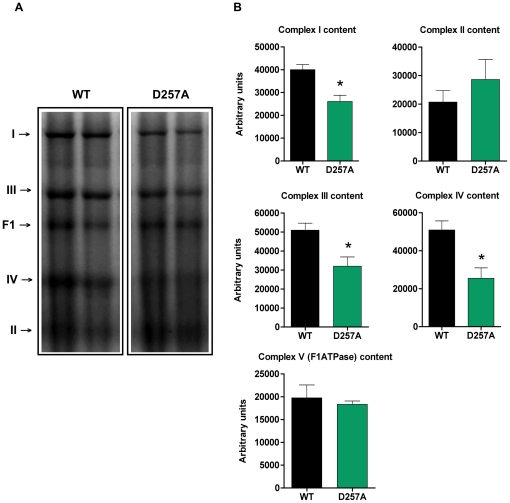
D257A mice display decreased content of ETC Complexes I, III and IV compared to WT.(A) The total content of ETC complexes I, II, III, IV and the F1 domain of the ATPase from skeletal muscle of 11-mo old WT and D257A mice (n = 7 per group) was determined using Blue Native PAGE electrophoresis followed by staining with commassie blue stain. Proteins were separated according to molecular weight. Representative blots are depicted. (B) Statistical analysis of ETC complexes content. Arbitrary units represent densitometry values normalized to total protein loaded measured by the Bradford assay. Mean values ±SEM are shown. *p<0.01.